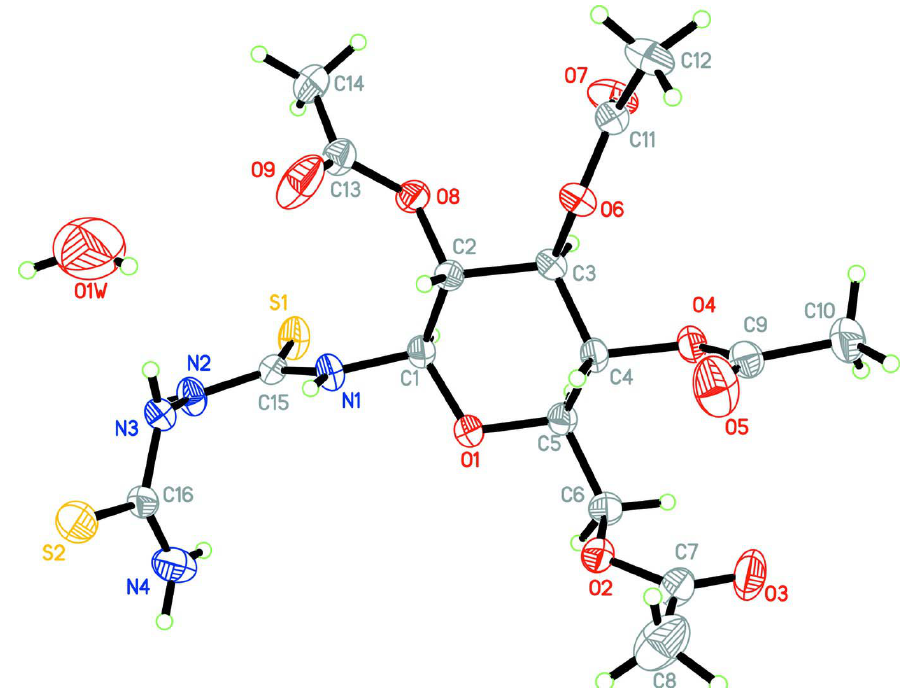
A view of the molecular structure of compound (I), showing the atom-labelling scheme and displacement ellipsoids drawn at the 50% probability